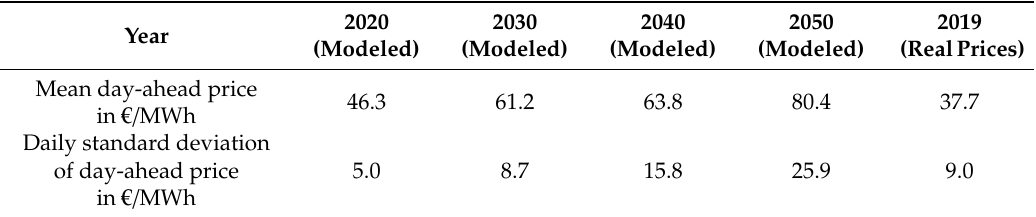
Table 4. Modeled mean day-ahead prices and standard deviation of day-ahead prices for the